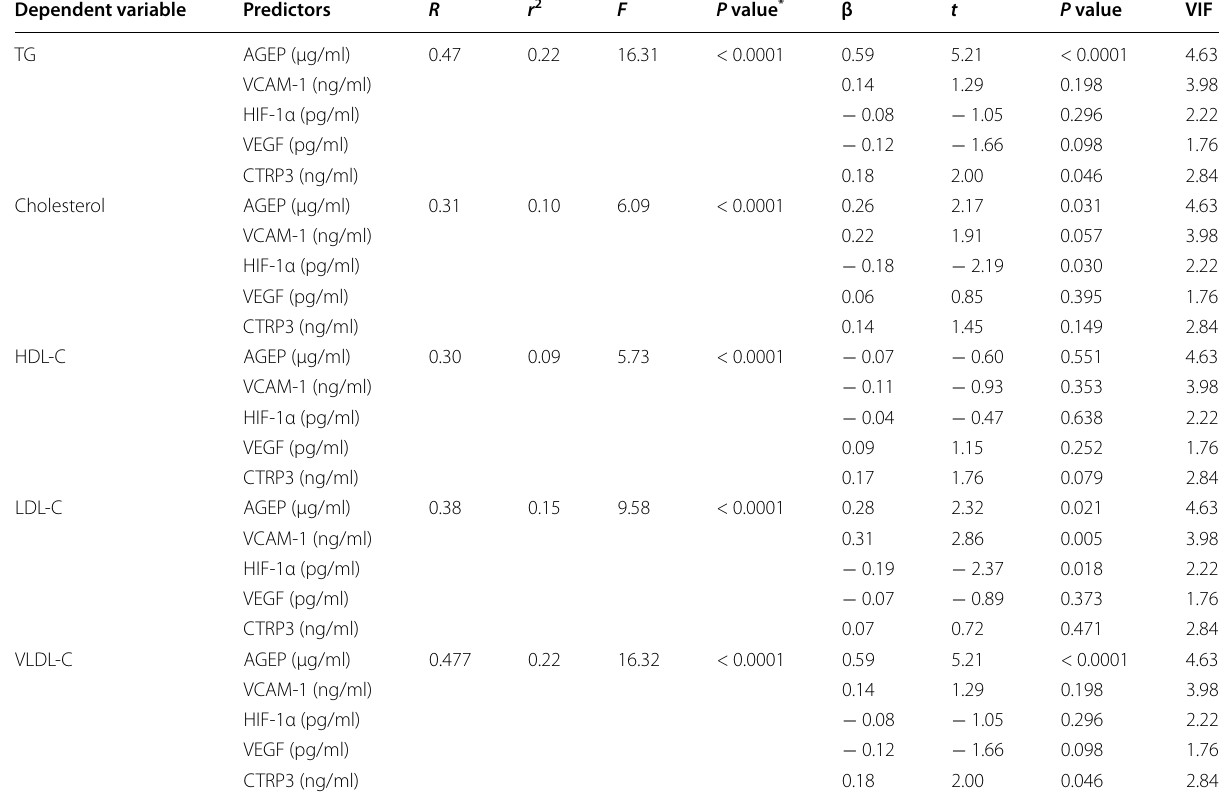
Table 7 Multiple linear regression analysis for the association of serum levels of AGEP, VCAM-1, HIF-1α, VEGF, and CTRP3 with the lipid